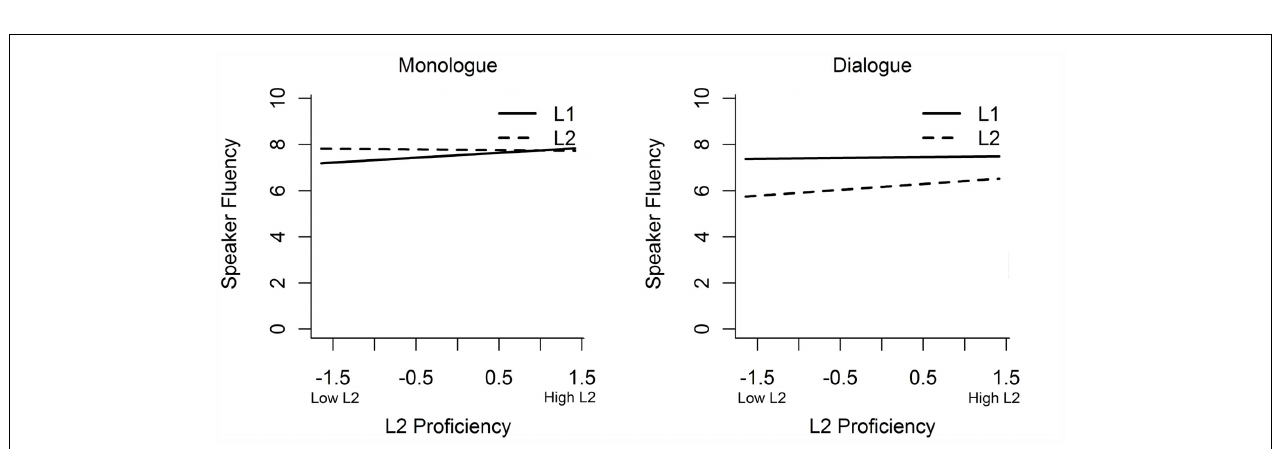
FIGURE 4 | Graphical representation of partialed effects from model fits of L2 proficiency on the speaker fluency in L1 and in L2 across monologues (left panel) and dialogues (right panel). Speaker fluency was lower in L2 than in L1 but only in dialogues. Speaker fluency was not different in L2 vs. L1 in